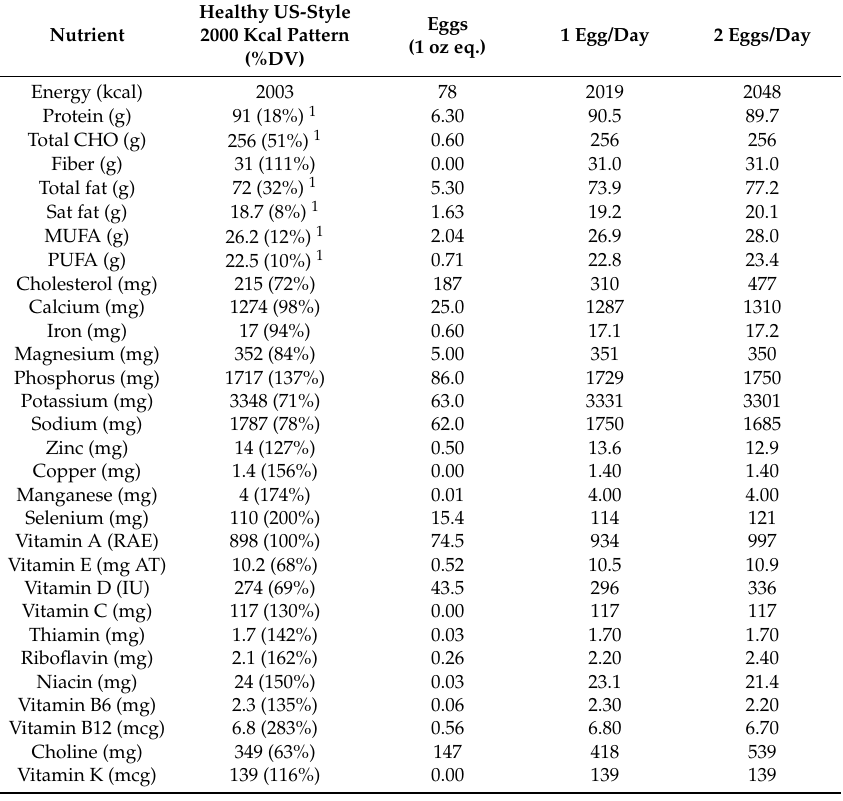
Table 4. Food pattern modeling incorporating eggs as a substitute for red and/or processed meat.